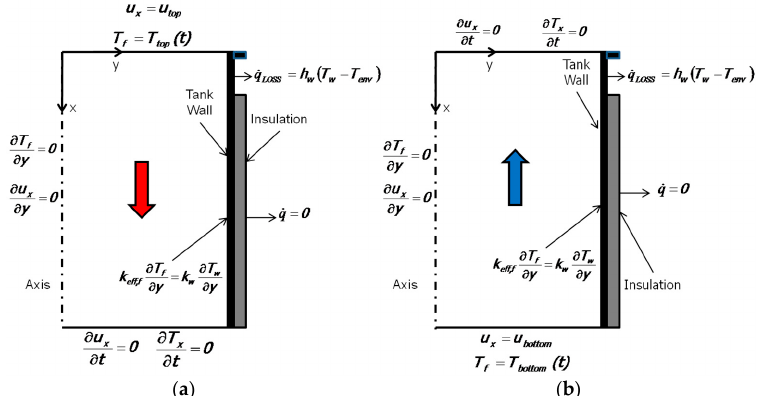
Figure 2. Boundary conditions of CFD model ( a ) charging phase ( b ) and discharging